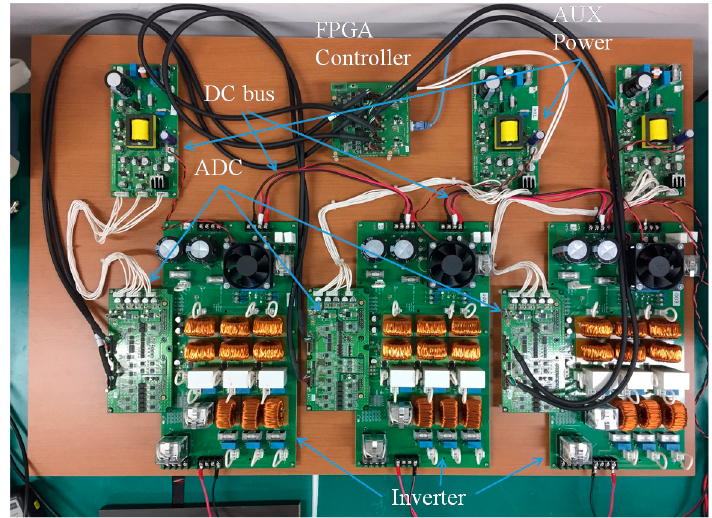
Figure 7. The experimental inverters system. AUX: Auxiliary.